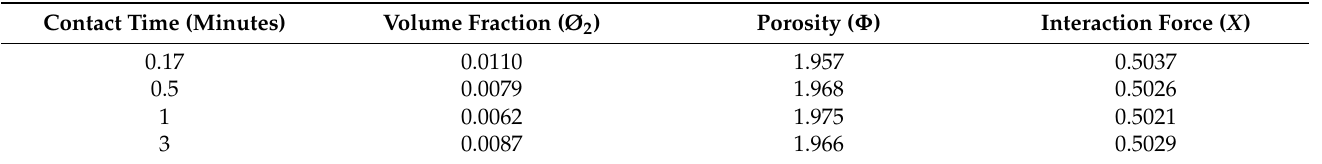
Table 6. Swelling structure parameters of ZL–CH hydrogel.